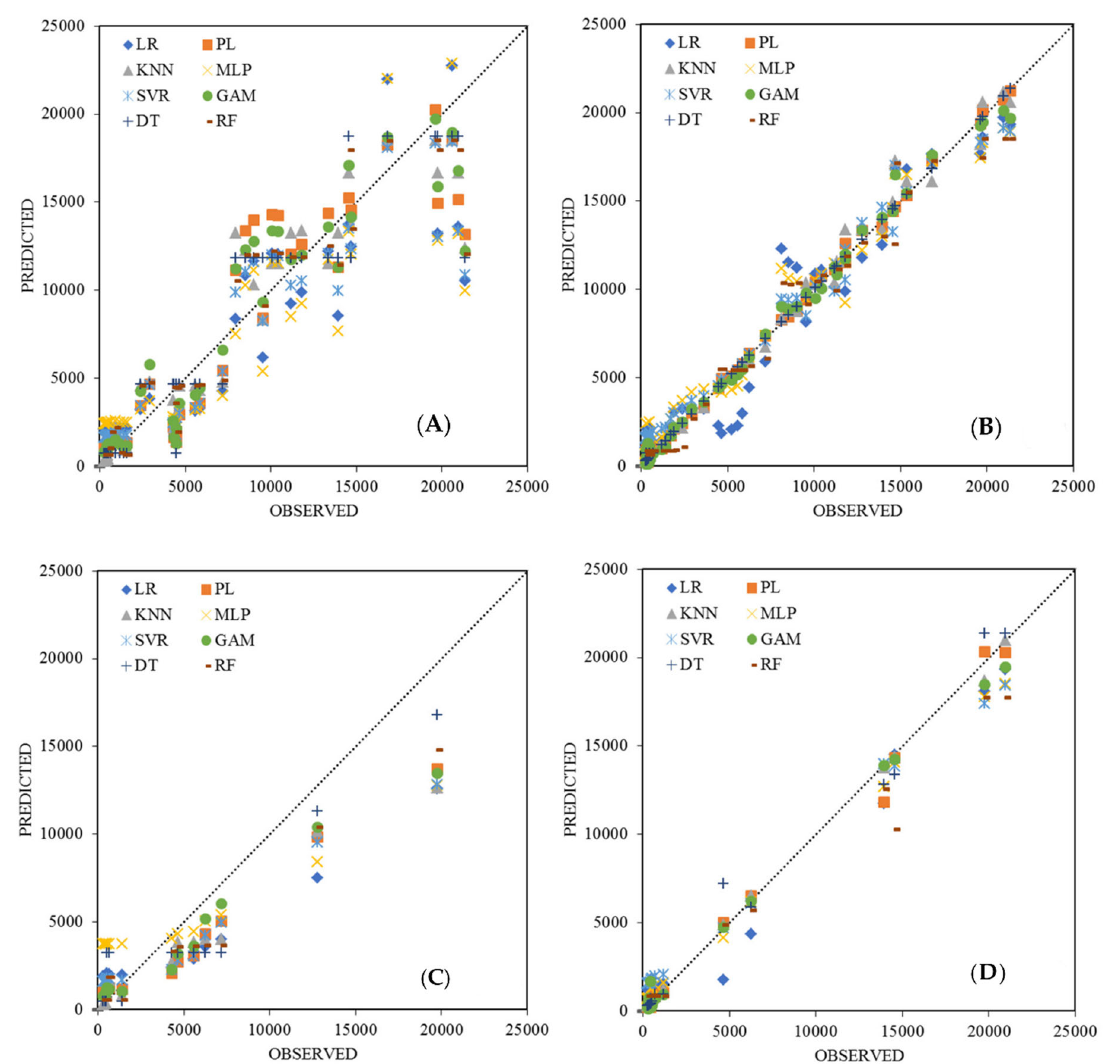
Figure 6. Visualisation of the number of active cases recorded versus model prediction in WWTP A: ( A , B ) model predictions against recorded data for training subset under univariate and multivariate inputs, respectively, and ( C , D ) the same plots for the testing subset.